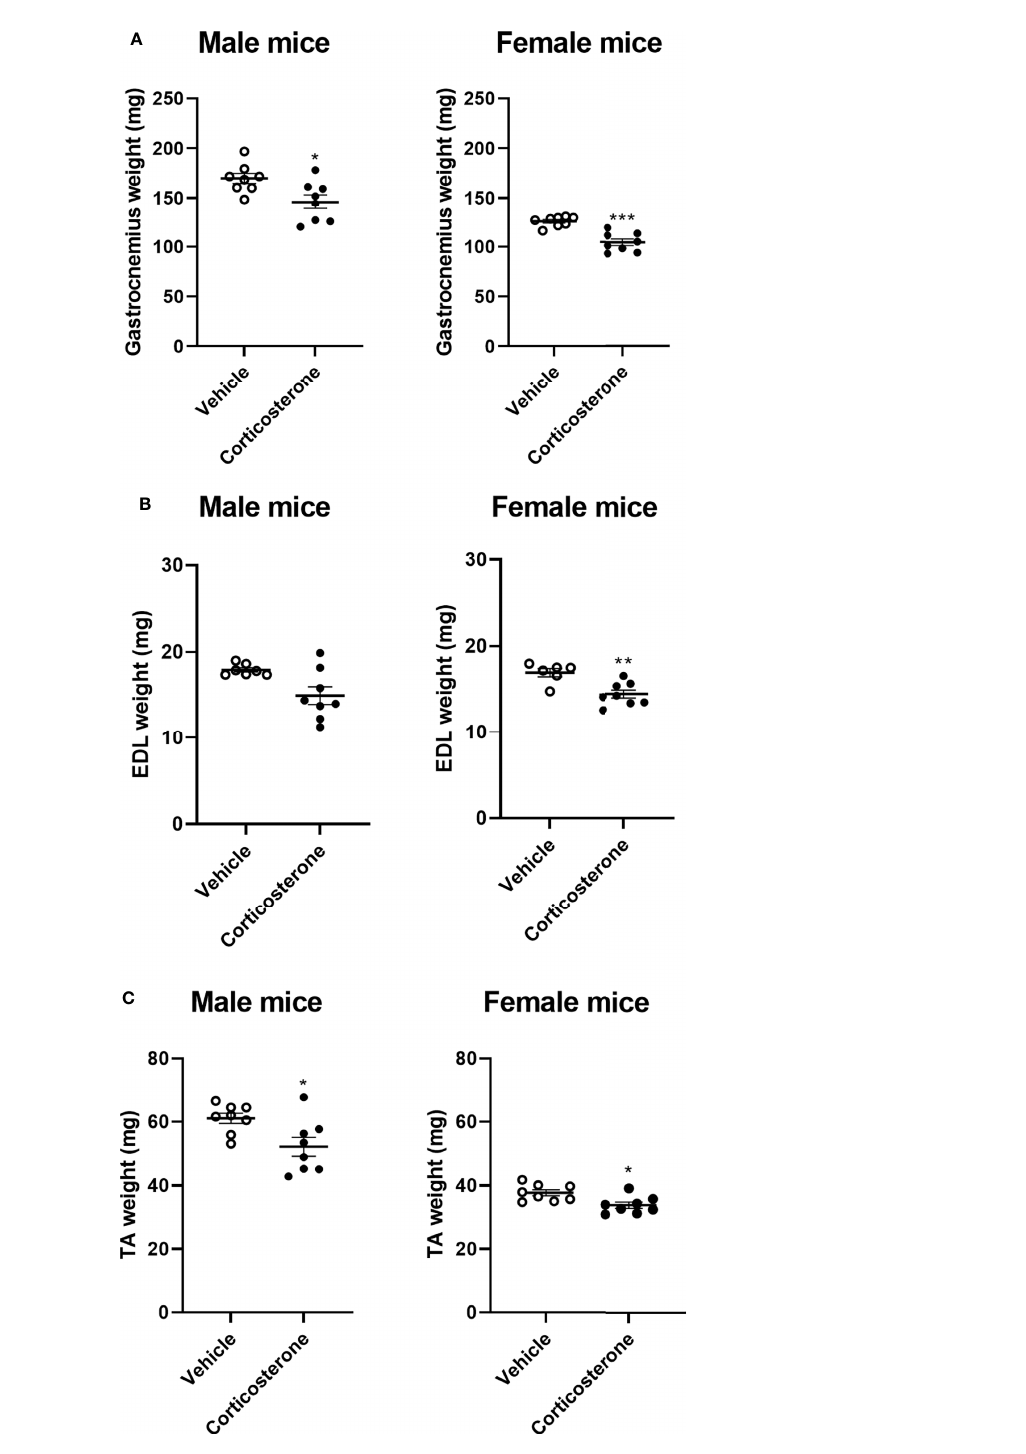
FIGURE 2 | Corticosterone treatment causes muscle atrophy in male and female mice. The effect of corticosterone treatment on tissue weight of (A) gastrocnemius, (B) extensor digitorum longus (EDL) and (C) tibialis anterior (TA) of male and female C57BL/6J mice. N=8 mice/group. *p<0.05 vs. Vehicle, **p<0.01 vs. Vehicle, ***p<0.001 vs. Vehicle. Statistical signi fi cance was calculated using an unpaired Student ’ s t-test.